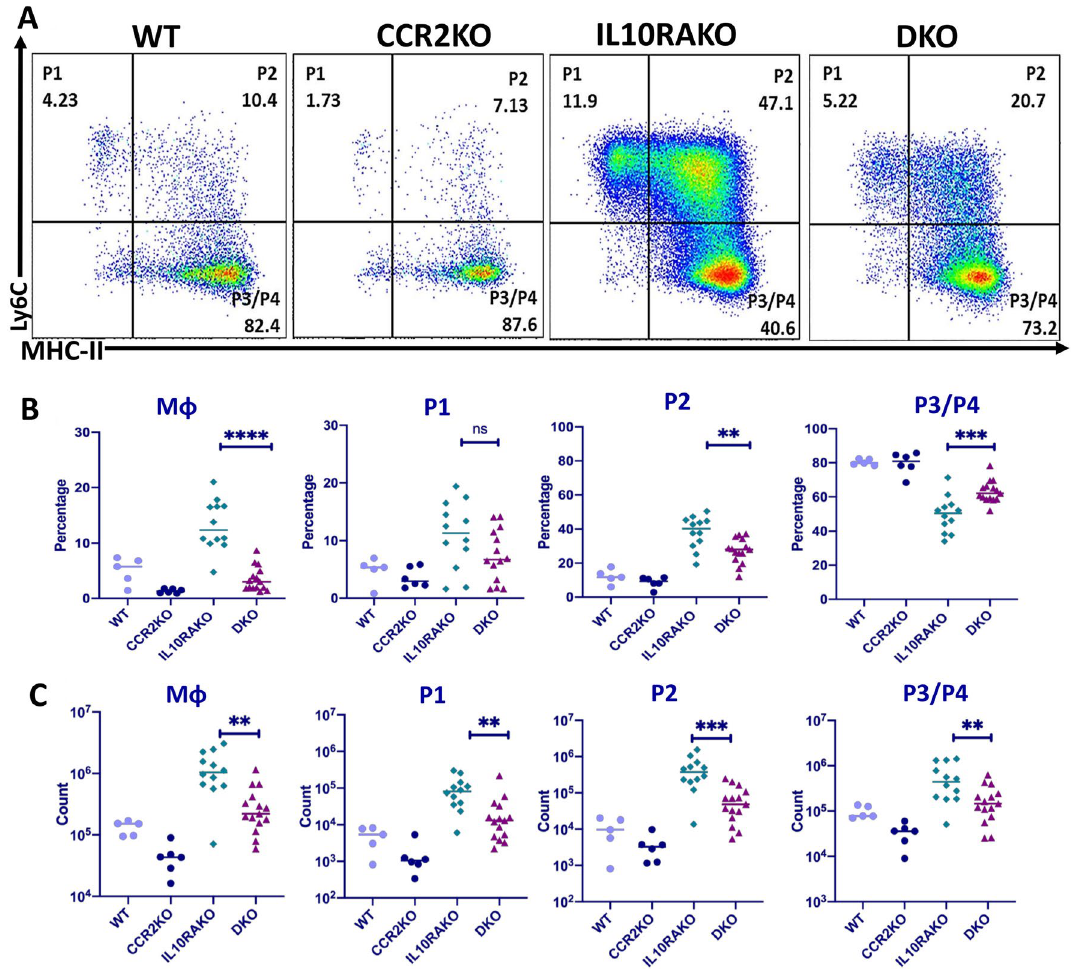
Figure 2. The absence of CCR2 inhibits the accumulation of immature macrophages in the colon of IL10RA- deficient mice. ( A ) Representative plots showing the distribution of P1 (Ly6C + MHCII - ), P2 (Ly6C + MHCII + ) and P3/P4 (Ly6C - MHCII + ) CD11b + CD64 + lamina propria macrophages as determined by flow cytometry in animals of the indicated genotype. ( B ) Percent and ( C ) Absolute number of LP macrophages in groups of WT (n = 5), CCR2KO (n = 6), IL10RAKO (n = 12) and DKO (n = 15) mice determined by flow cytometry as in ( A ). Please note that the y-axis on the graphs in ( C ) are log